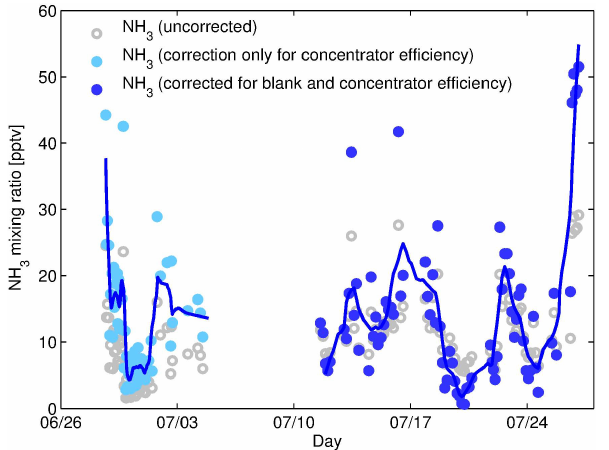
Fig. 6. Mass flow controllers (MFC) settings (top panel) and sum- mary of dimethylamine (DMA) mixing ratio (in pptv) measured (lower panel): uncorrected (grey), corrected for sampling efficiency (orange), and corrected for sampling efficiency and concentrator column efficiency (filled red). The continuous line is a smoothing function through the final data. A logarithmic scale was used to vi- sualise the data of the second half of the campaign (around